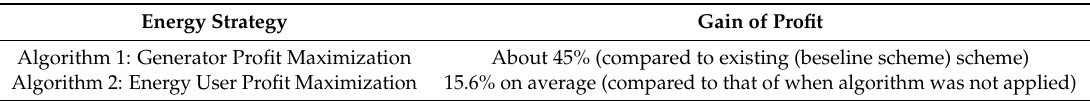
Table 4. The gain of monetary profit from the proposed algorithm.